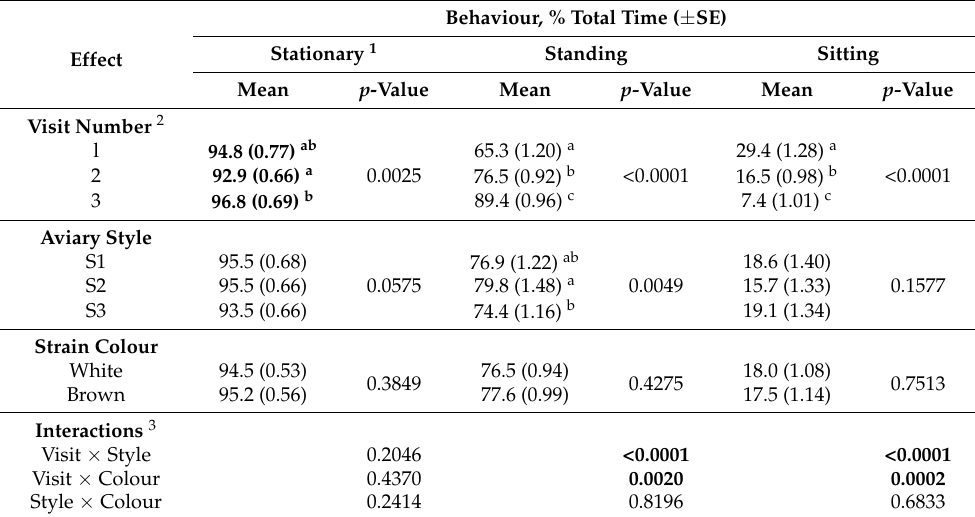
Table 4. Least square means ( ± standard error) of the percentage of total time brown- and white- feathered strains of layer pullets housed in three different styles of commercial rearing aviary systems of increasing structural complexity spent on stationary behaviours throughout the rearing period.